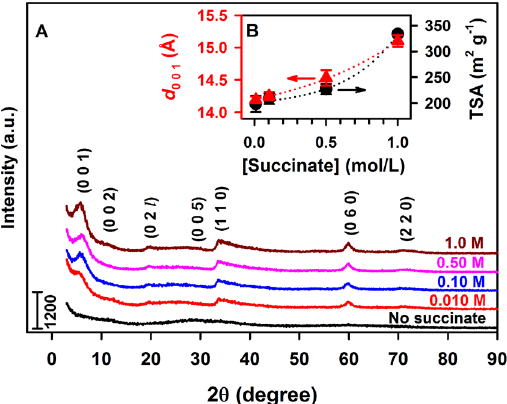
Figure 1. Powder XRD and TSA characterization of sauconite synthesized at pH 0 6.3 and 90 °C during 20 h under variable succinate concentration. ( A ) ( A ) XRD diffractograms for [succinate] listed above each trace. Numbers, e.g., (0 0 1), indicate basal reflections of the identified phases. ( B ) The layer to layer distance for 2:1 sauconite ( d 0 0 1 , red solid triangle) and TSA (black solid circle) for traces in ( A ) vs